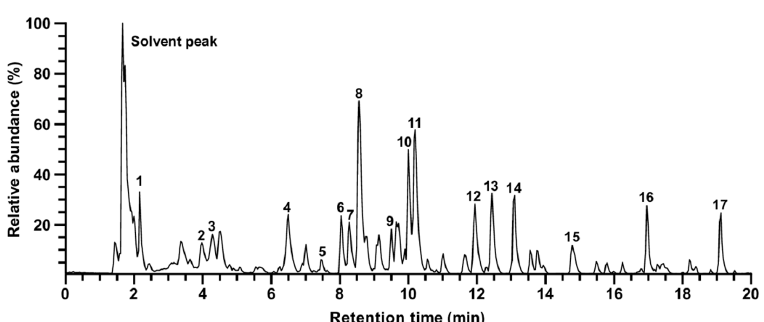
Figure 3. RPE inhibits collagen degradation and reverses biomarkers of skin aging. ( A ) Masson’s trichrome staining for the visualization of collagen and keratin fibers in mouse skin tissue. Collagen fibers appear blue and keratin fibers appear red. The scale bar indicates 100 μ m. ( B ) Protein expres- sion of MMP − 1, COX − 2, and vinculin were determined in mouse tissue lysates using the corre- sponding antibody. Tissue lysates from three mice per group were used. Vinculin was used as a loading control.